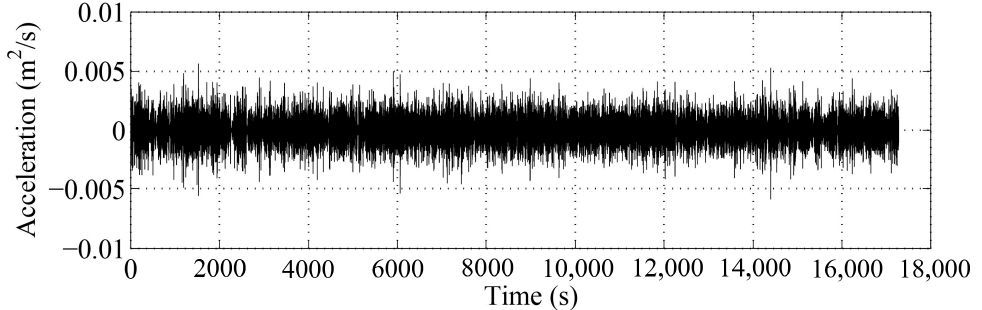
Figure 4. The measured time history responses of Acc 1. The power spectrum density function of the responses of Acc 1 is shown in Figure 5.